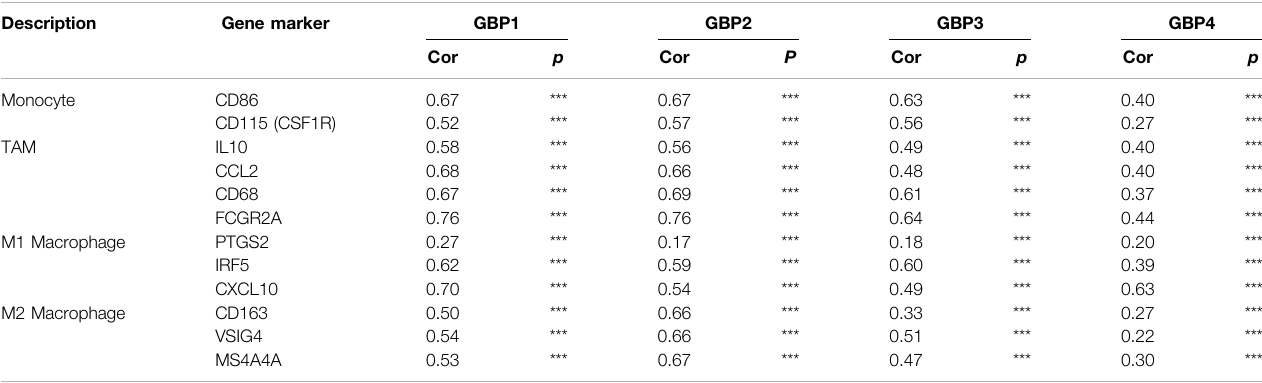
TABLE 5 | Correlation analysis between GBP1/2/3/4 and related markers of immune cells in LGG (GEPIA).